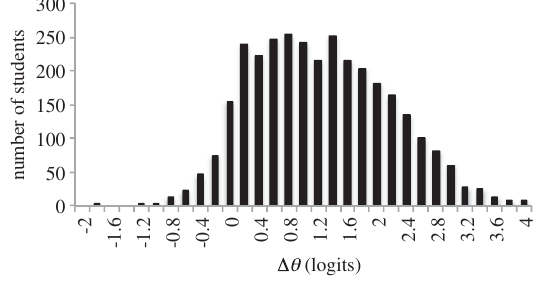
FIG. 5. The distribution of IRT-estimated gains ( Δ θ ) for all 3205 students in the data set.